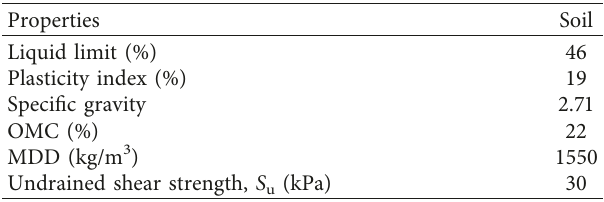
Table 1: Physical properties of soil.